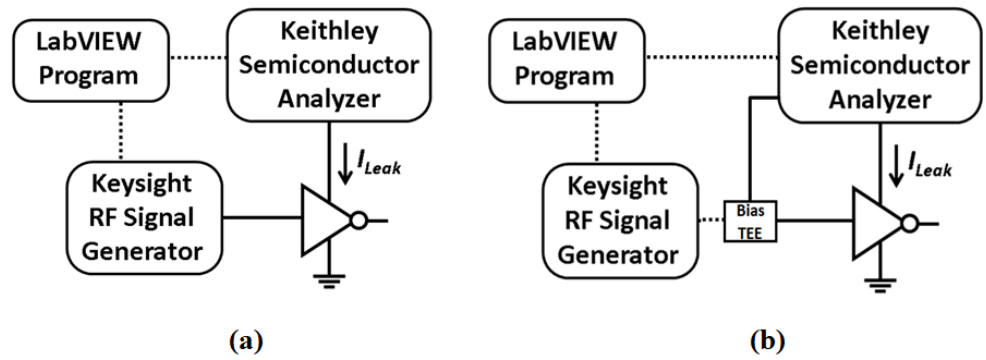
Figure 7. The block diagram of the experimental setup with the LabVIEW control program, measuring leakage current of ( a ) NMOS; ( b ) PMOS.